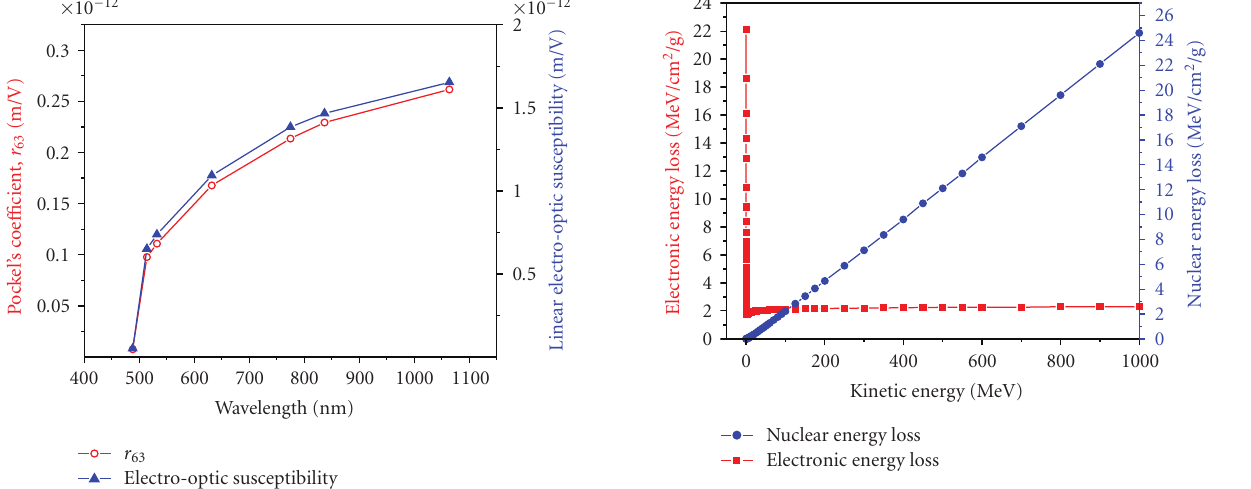
Figure 37: Variation of r 63 and electro-optic susceptibility with wavelength.